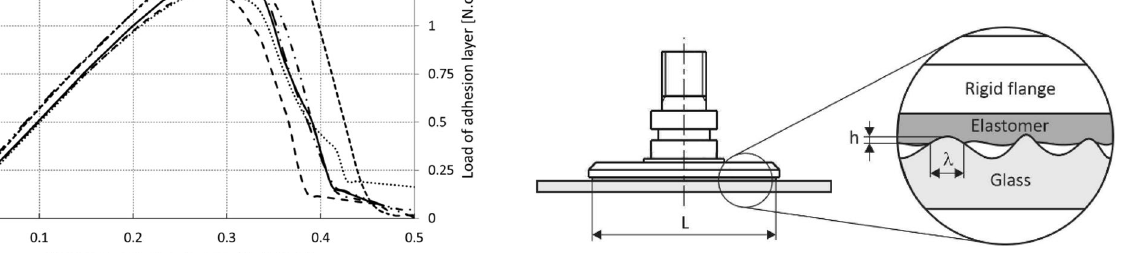
Fig. 14 “Pull to break” test of the adhesive layer